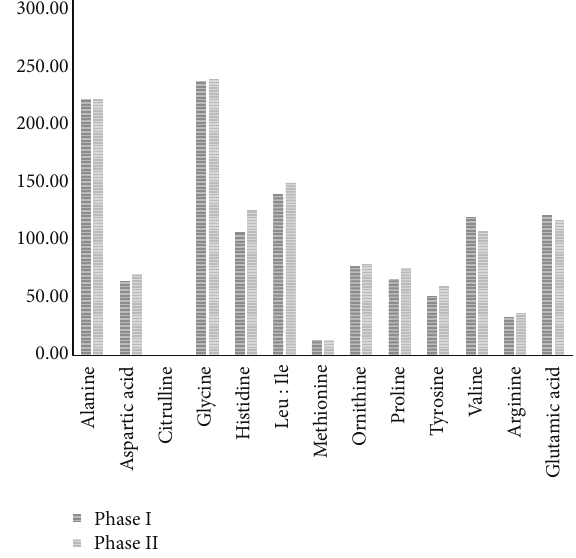
Figure 3: Comparison of measured AA levels in the two phases (70 samples in phase I and 66 samples of in phase